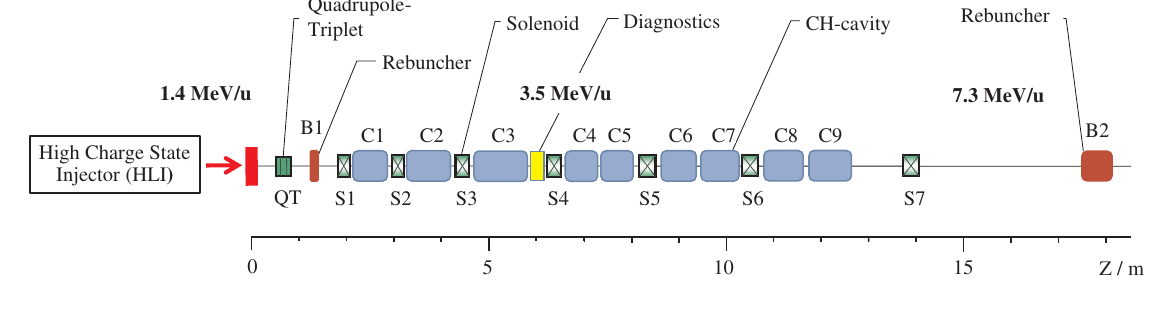
FIG. 1. General cw-linac layout.